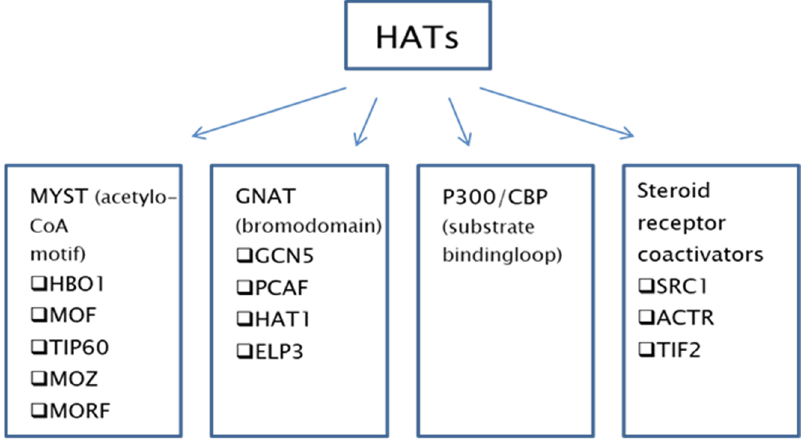
Figure 1. Differentiation of histone acetyltransferase subtypes based on the presence of catalytic